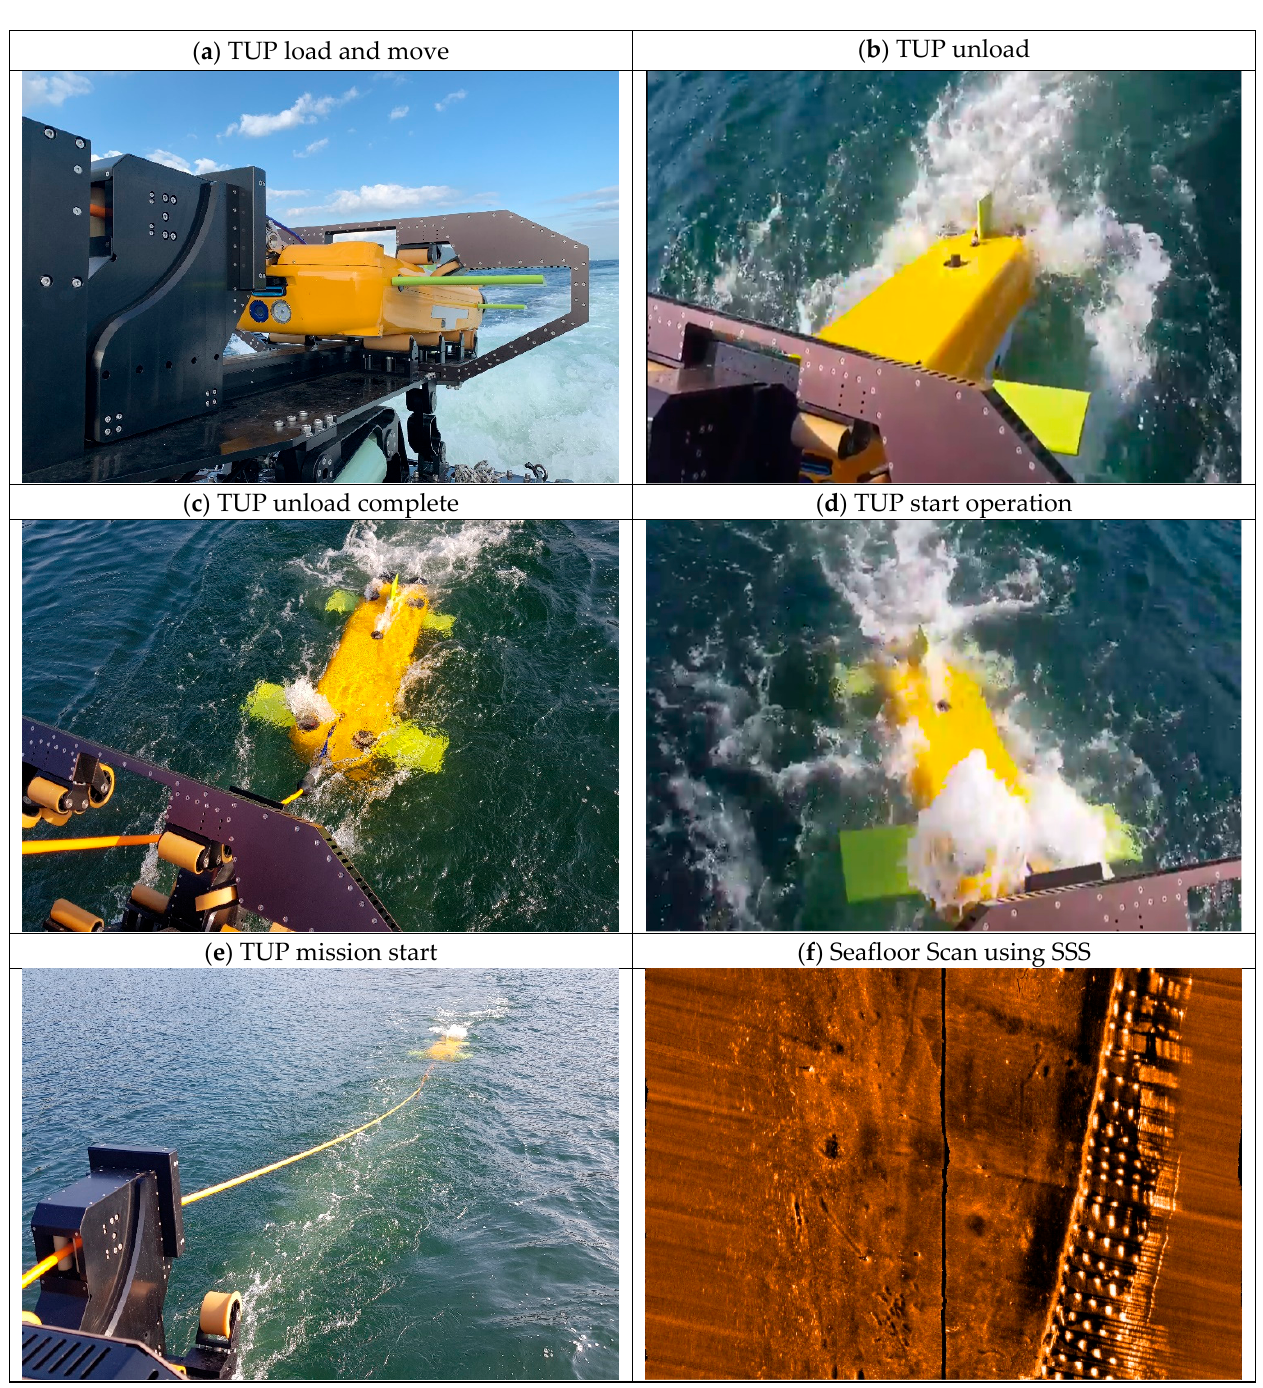
Figure 11. TUP operation sequence.